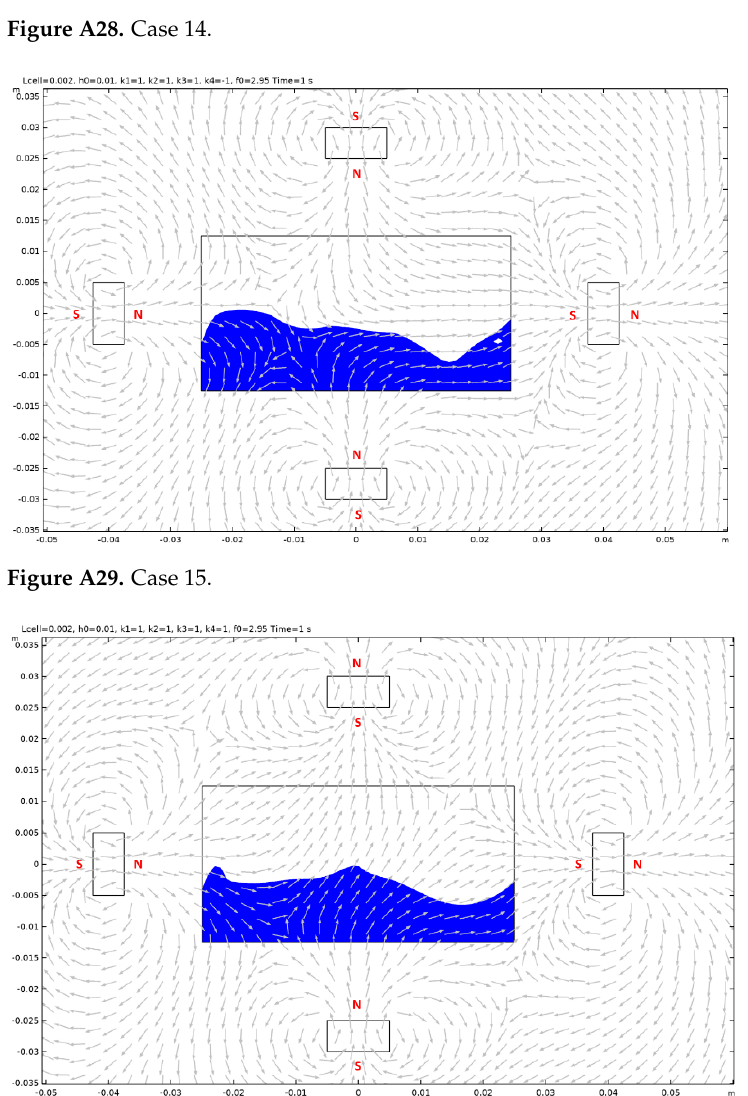
Figure A31. External Excitation.